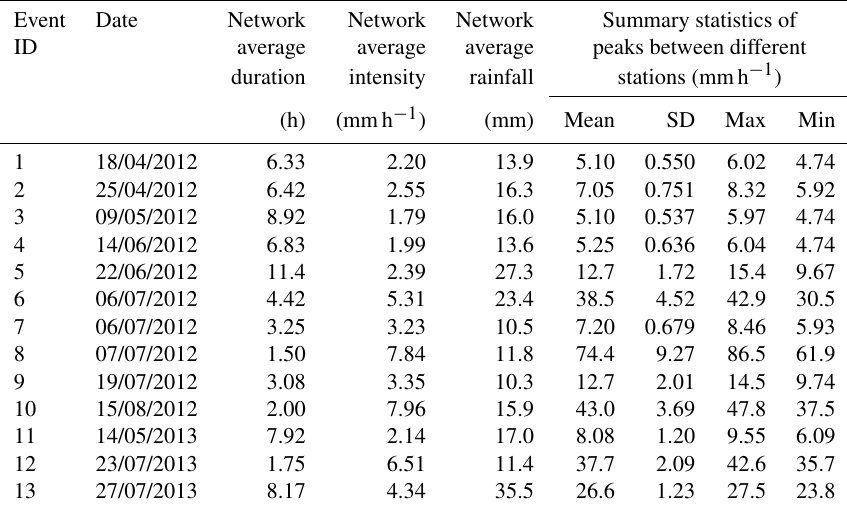
Table 1. Summary of events which yielded more than 10mm rainfall and lasted for more than 20min with summary statistics of event peaks (derived at 5min temporal averaging interval) from all